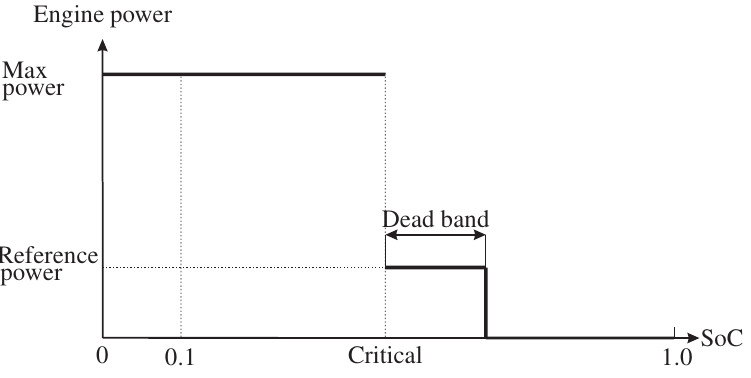
Figure 6. Two-points switching management